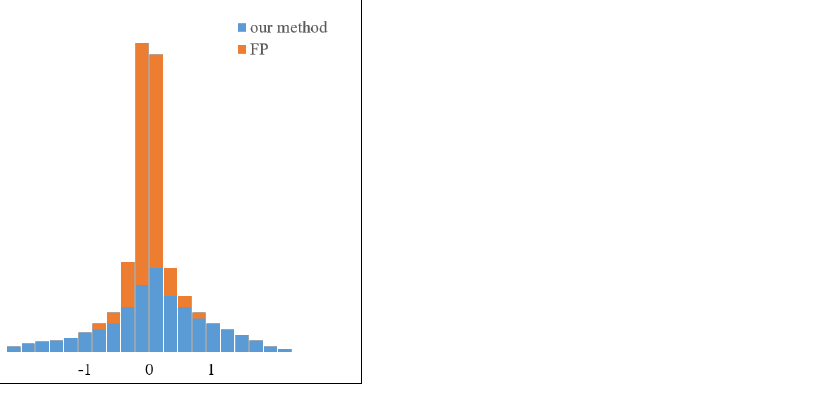
Figure 3. The full-precision weights in neural networks are always distributed around 0, and the data range is tiny enough. Their symbols are easily changed in the process of back propagation. Our method balances and normalizes the weights before binarization to make them more stable in the training